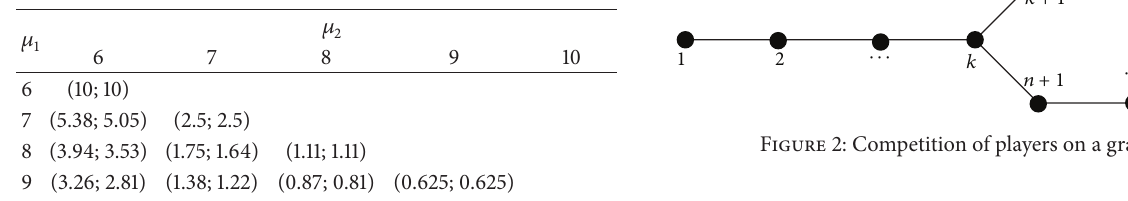
Table 7: The values (𝑃 1 , 𝑃 2 ) under 𝜆 = 10.